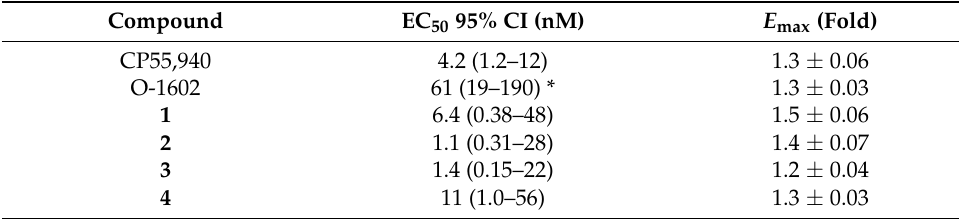
Table 2. p-ERK1/2 activation assay at h GPR55 a .